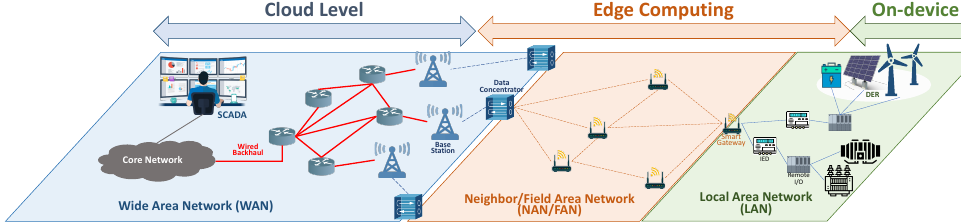
Figure 3. Communication categories interconnection [34,35,37]. Table 1. PAC application communication requirements